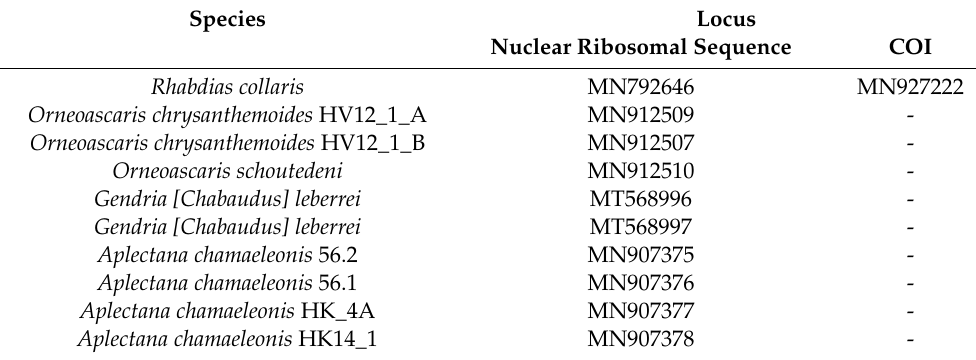
Table 2. Accession numbers of nuclear ribosomal sequences and mitochondrial COI sequences used for phylogenetic reconstruction.